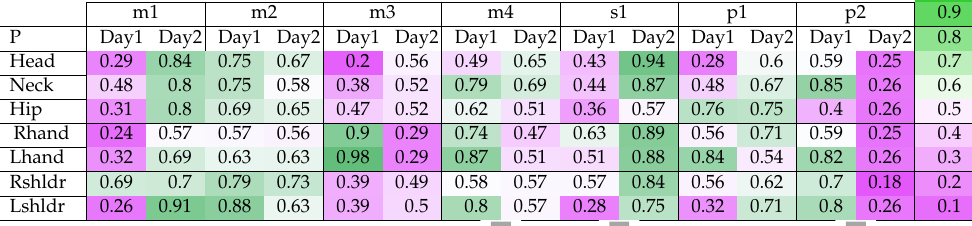
Table 2. The difference probabilities between Day 1 and Day 2 in the plots of MMSE versus body joint